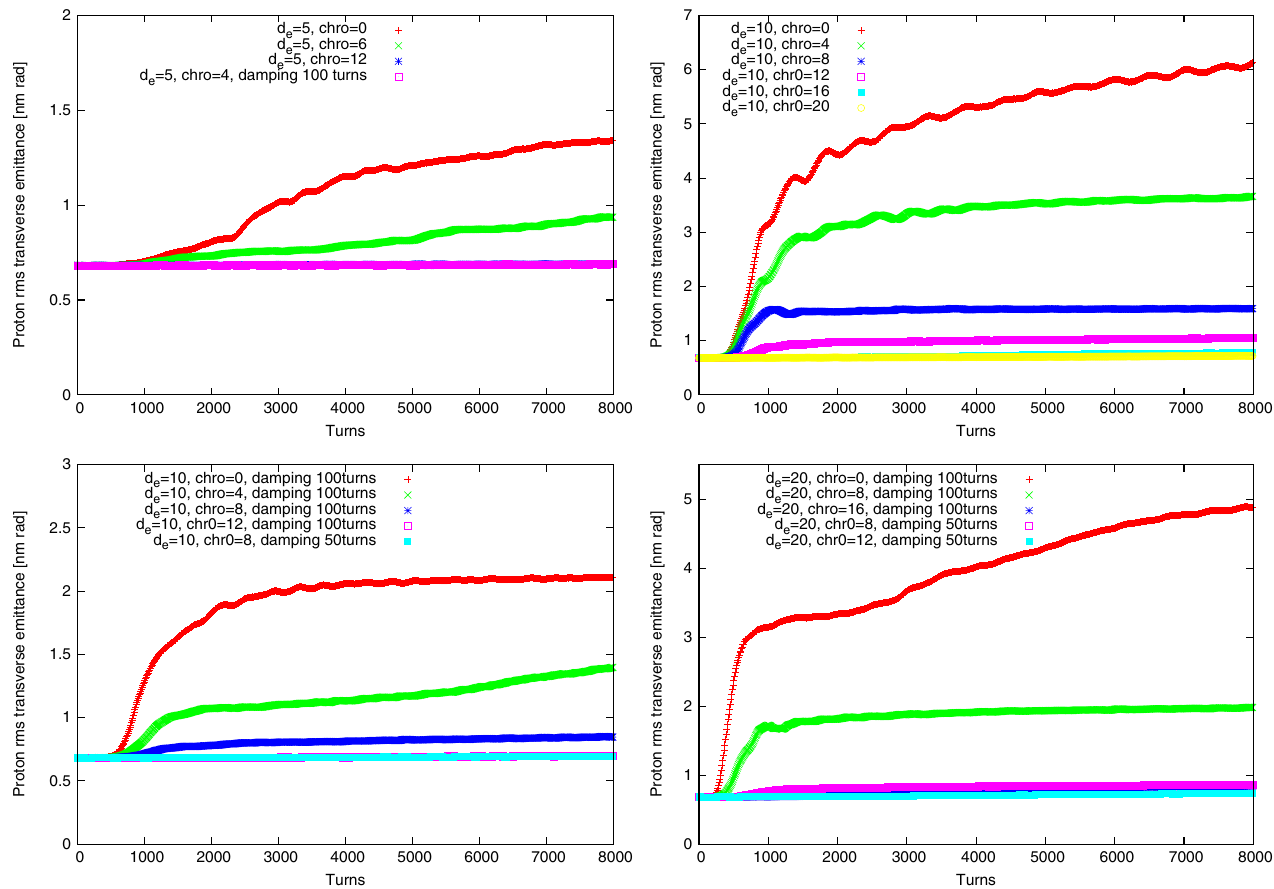
FIG. 5. The proton beam emittance growth due to the kink instability for different chromaticities at the disruption parameters 5 (in the top left figure) and 10 (in the top right figure). The top left figure also includes the case with transverse damper. The bottom left and bottom right figures correspond to the proton beam emittance growth with chromaticities together with transverse damper for d e ¼ 10 and 20, respectively. The beam-beam parameters of the proton beam in all cases are 0.015.